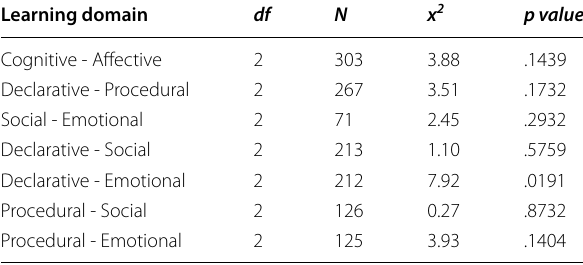
Table 3 Proportion of learning domains and grade bands: chi‑ square statistics (x 2 ) test for goodness of fit Learning domain